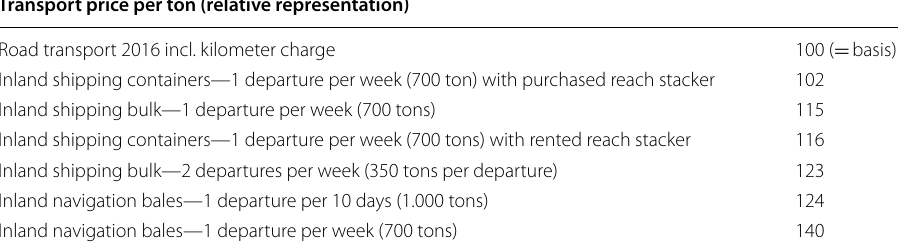
Table 8 Cost index of road transport versus inland shipping solutions. Source: (De Vylder et al., 2016) Transport price per ton (relative representation) Road transport 2016 incl. kilometer